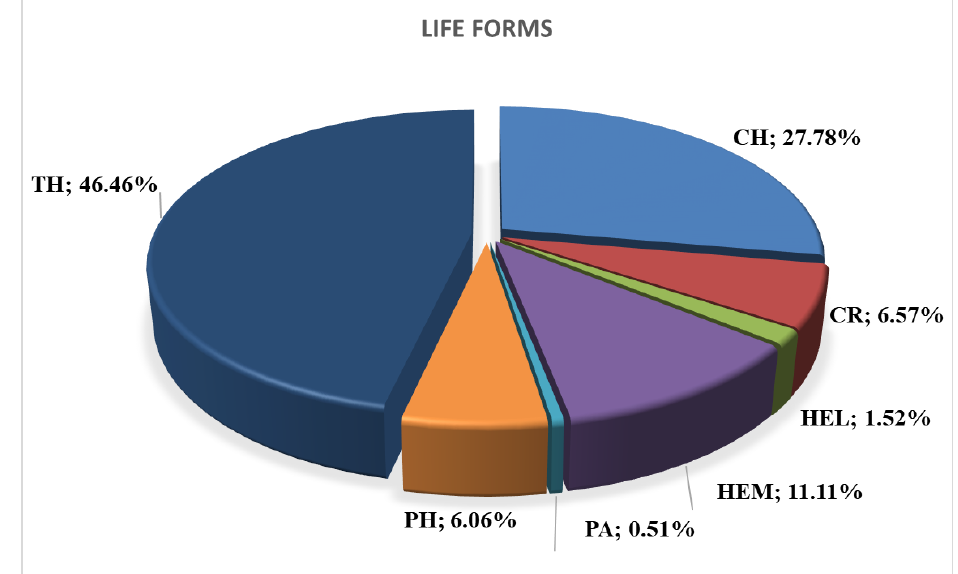
Figure 5. Life form spectrum of the recorded species in Jabal Al-Ward region. TH = Therophytes, CH = Chamaephytes, HEM = Hemicryptophytes, PH = Phanerophytes, GE = Geophytes, CR = Cryptophytes, HEL = Helophytes, PA = Parasites.